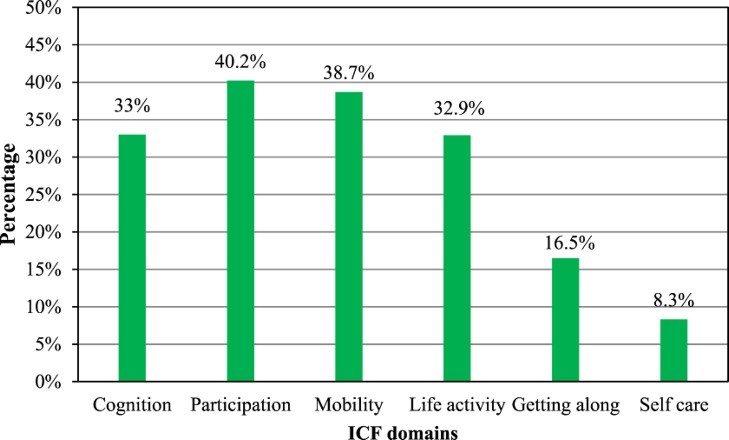
Functional limitations in the six domains.